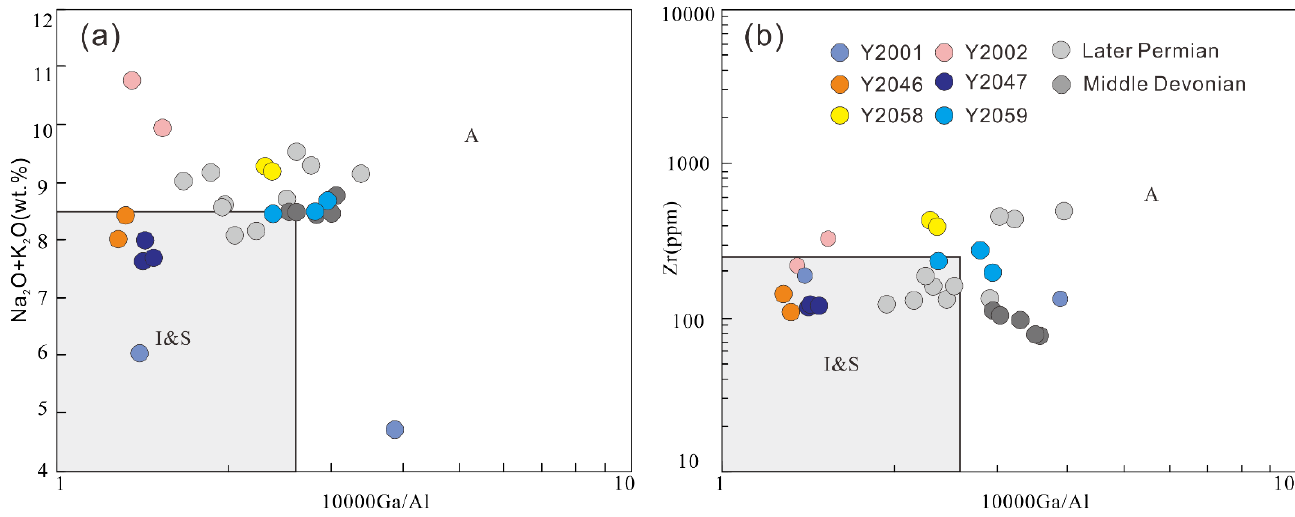
Figure 10. ( a ) Na 2 O + K 2 O vs 10,000 Ga/Al, and ( b ) Zr vs 10,000 Ga/Al diagrams showing the A-type signature of the analyzed samples [57]. Middle Devonian rocks are from [19]; Late Permian rocks are from [17].